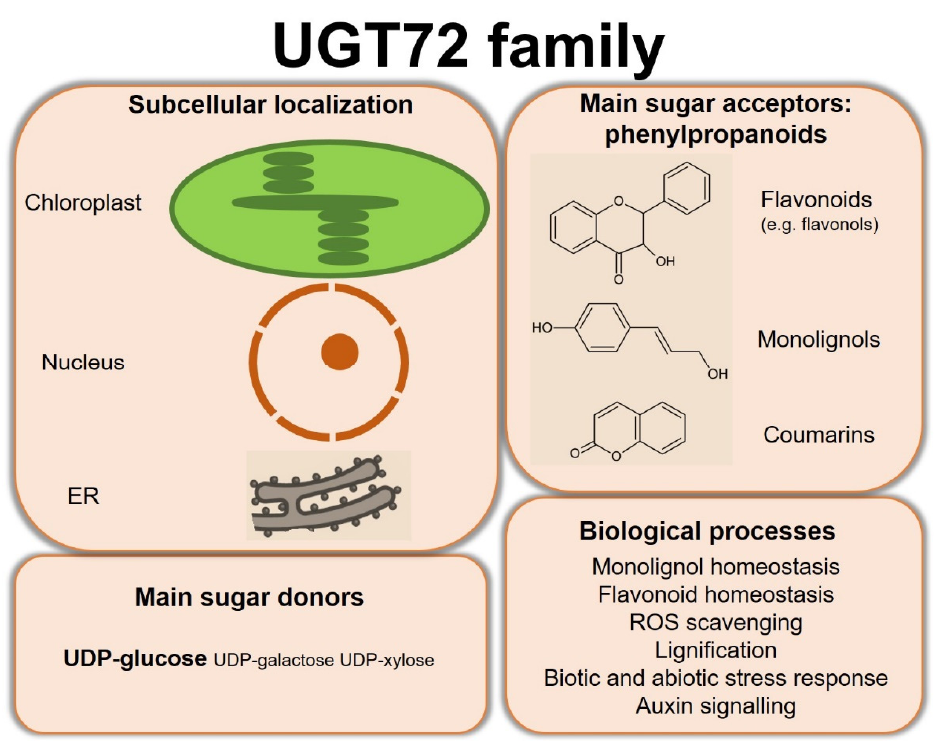
Figure 5. Summary of the subcellular localization and main substrates of UGT72s, as well as the biological processes in which investigated enzymes are involved. ER, endoplasmic reticulum.